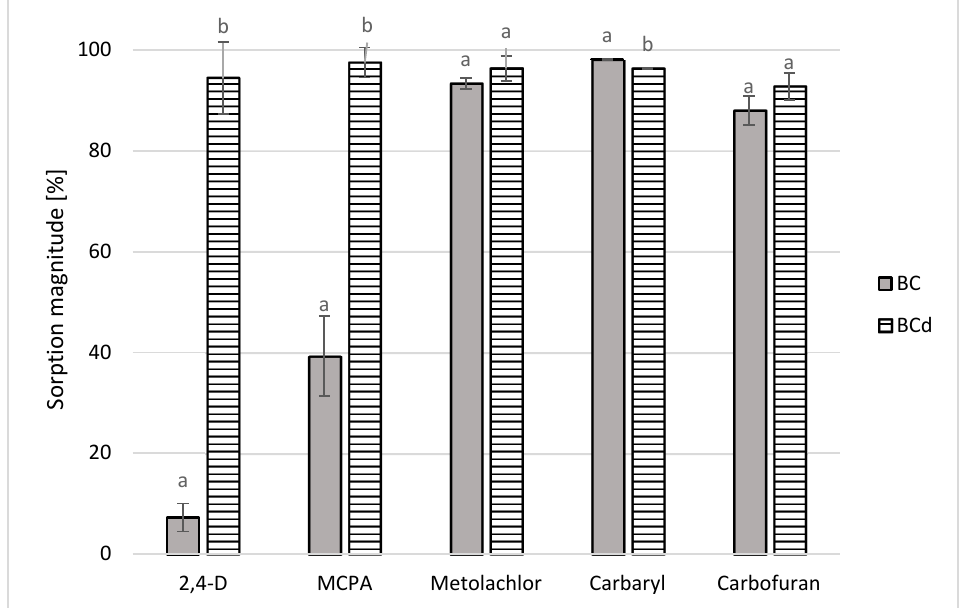
Figure 3. Comparison of the sorption magnitude of the tested pesticides on biochars before (BC) and after ash removal (BCd). Error bars represent ± values of the standard deviations of triplicate samples. Letters a and b indicate significant differences between sorption magnitude of each pesticide on pristine and deashed biochar ( p < 0.05).